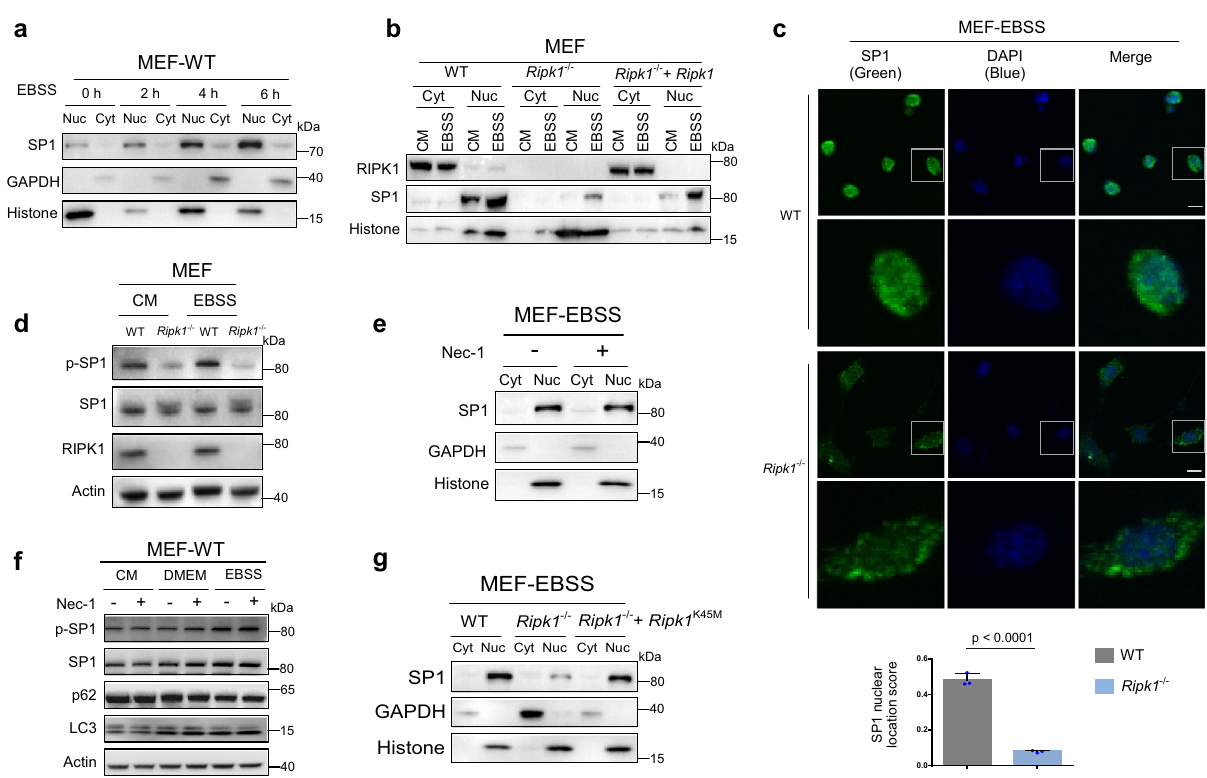
Fig. 7 RIPK1 de fi ciency inactivates SP1 by inhibiting SP1 nuclear translocation. a Nuclear (nuc) and cytosol (cyt) proteins of MEFs cultured in EBSS for 0, 2, 4, or 6 h were extracted and used to determine SP1 subcellular levels by western blot. b Cytosol (cyt) and nuclear (nuc) proteins of WT, Ripk1 − / − , and Ripk1 − / − + Ripk1 MEFs were extracted and used to determine SP1 subcellular levels by western blot. The medium was changed to the fresh culture medium (CM) or EBSS for 4 h before harvest. c Representative immuno fl uorescence images depicting the levels and localizations of Sp1 (green) in WT, Ripk1 − / − and Ripk1 − / − + Ripk1 MEFs. Cells were cultured in EBSS for 4 h before collection. The nuclei were stained with DAPI (blue). Scale bar represents 10 μ m. Quanti fi cation of the nuclear staining of SP1 is presented in the bar graph. SP1 nuclear location score was computed as (the green and blue overlapping area)/(total green area + total blue area). The results were averaged from three independent immuno fl uorescence images. Bar graphs represent mean ± SD. d Western blot analyses of p-SP1 (T739) and SP1 levels in WT and Ripk1 − / − MEFs. The medium was changed to the fresh culture medium (CM) or EBSS 4 h before harvest. e Cytosol (cyt) and nuclear (nuc) proteins of Nec-1 (100 μ M, 24 h) treated or untreated MEFs were extracted and used to determine SP1 subcellular levels by western blot. The medium was changed to EBSS with or without Nec-1 4 h before harvest. f Western blot analyses of p-SP1 (T739), SP1, p62, and LC3 levels responding to Nec-1 treatment. The medium was changed to the fresh culture medium (CM), DMEM (serum-free), or EBSS for 4 h before harvest. g Cytosol (cyt) and nuclear (nuc) proteins of WT, Ripk1 − / − , and Ripk1 − / − + Ripk1 K45M MEFs were extracted and used to detect SP1